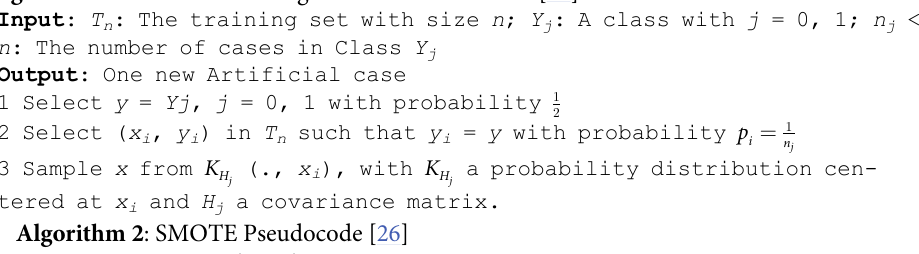
Algorithm 2 : SMOTE Pseudocode